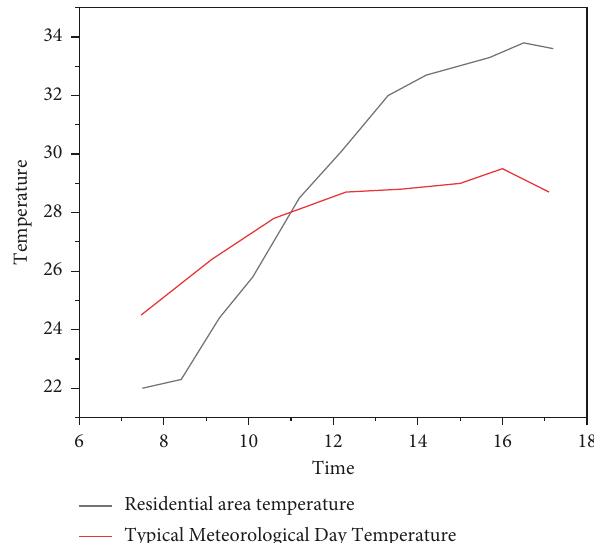
Figure 6: Comparison of heat resistance of building